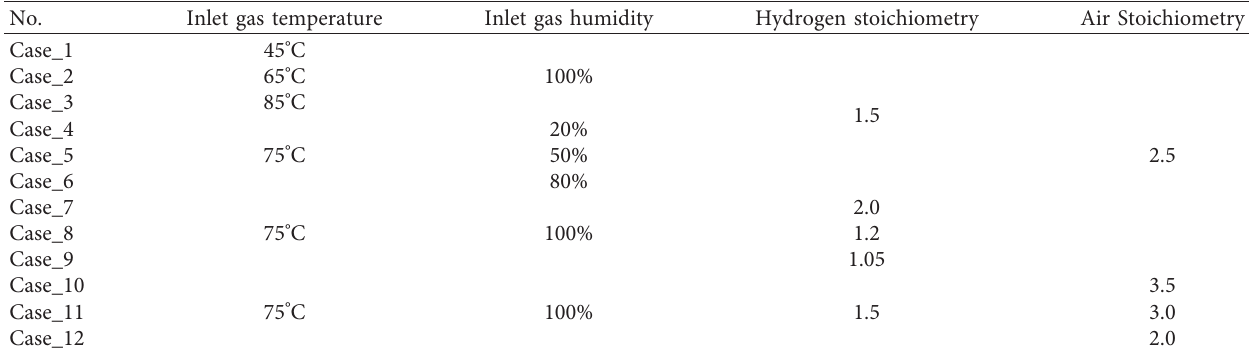
Figure 3: Visualization platform of the single fuel cell. Table 1: Different operation conditions of the visual single fuel